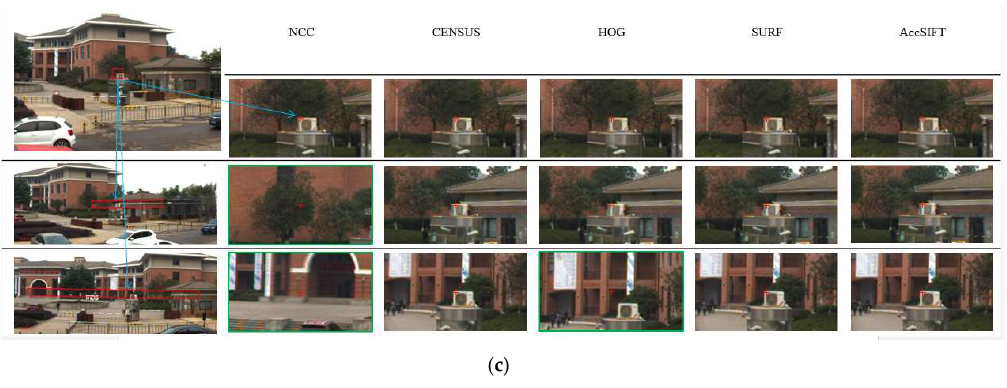
Figure 9. Performances of template matching with different descriptors on the Wuhan data. From left to right: reference image and the two adjacent search image, the results of the NCC, CENSUS, HOG, SURF and AccSIFT descriptors respectively.